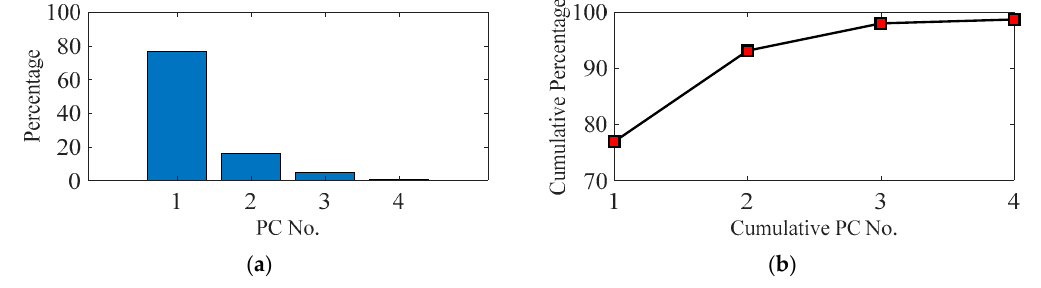
Figure 6. ( a ) Contributions of the single PC; and ( b ) contributions of the added PCs.